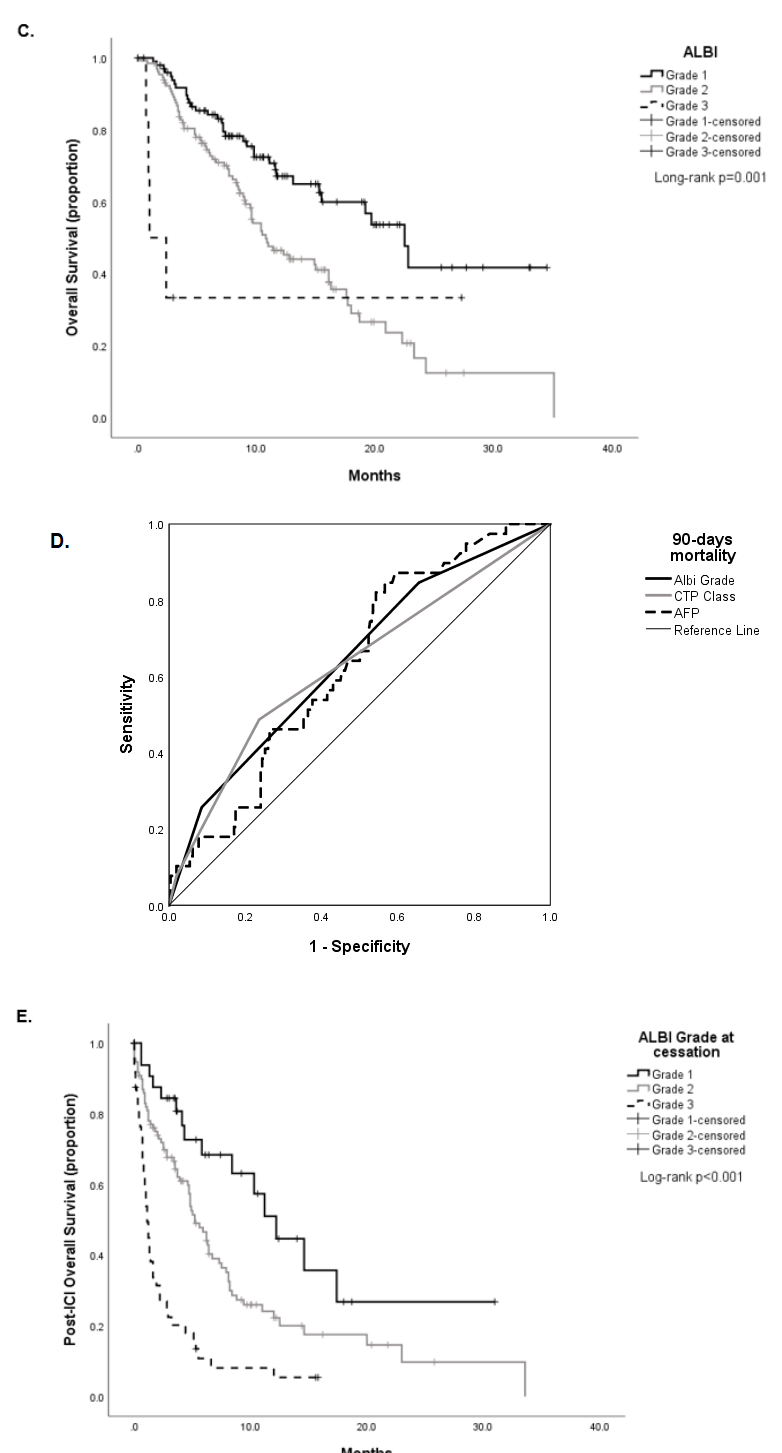
Figure 3. Prediction of overall survival by ALBI grade and CTP class in unselected HCC patients treated with ICI ( n = 330, A,B ) and in patients fulfilling CTP A criteria ( n = 239, C ). Receiver operating characteristic (ROC) curve analysis demonstrating the role of ALBI, CTP class, and AFP in predicting 90-days mortality from ICI commencement ( D ). The prognostic role on post-immunotherapy survival (PIOS) of the ALBI grade at the moment of ICI cessation ( E ).